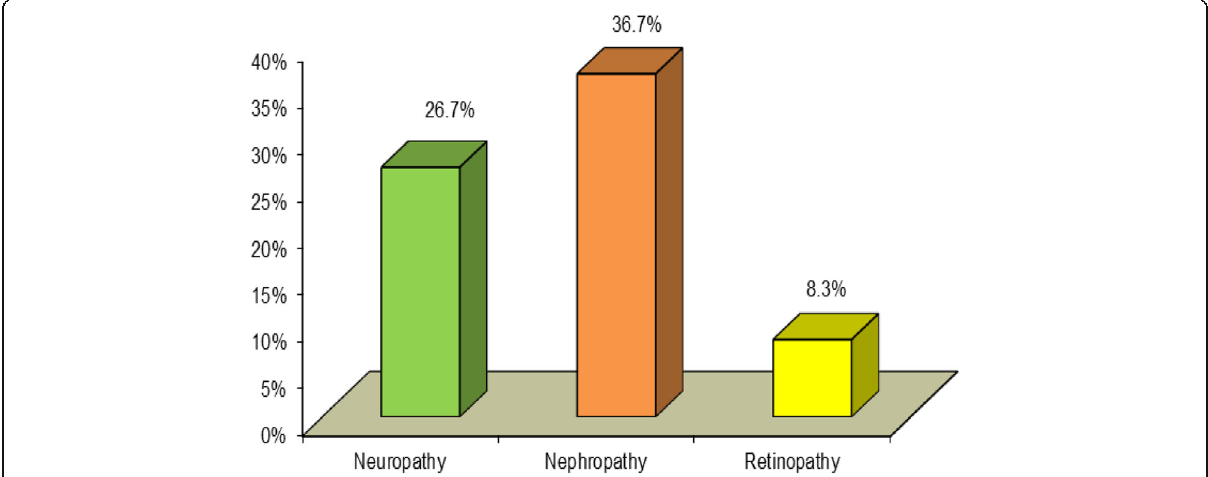
Fig. 1 Column chart showing frequency of microvascular complications in the studied diabetic group